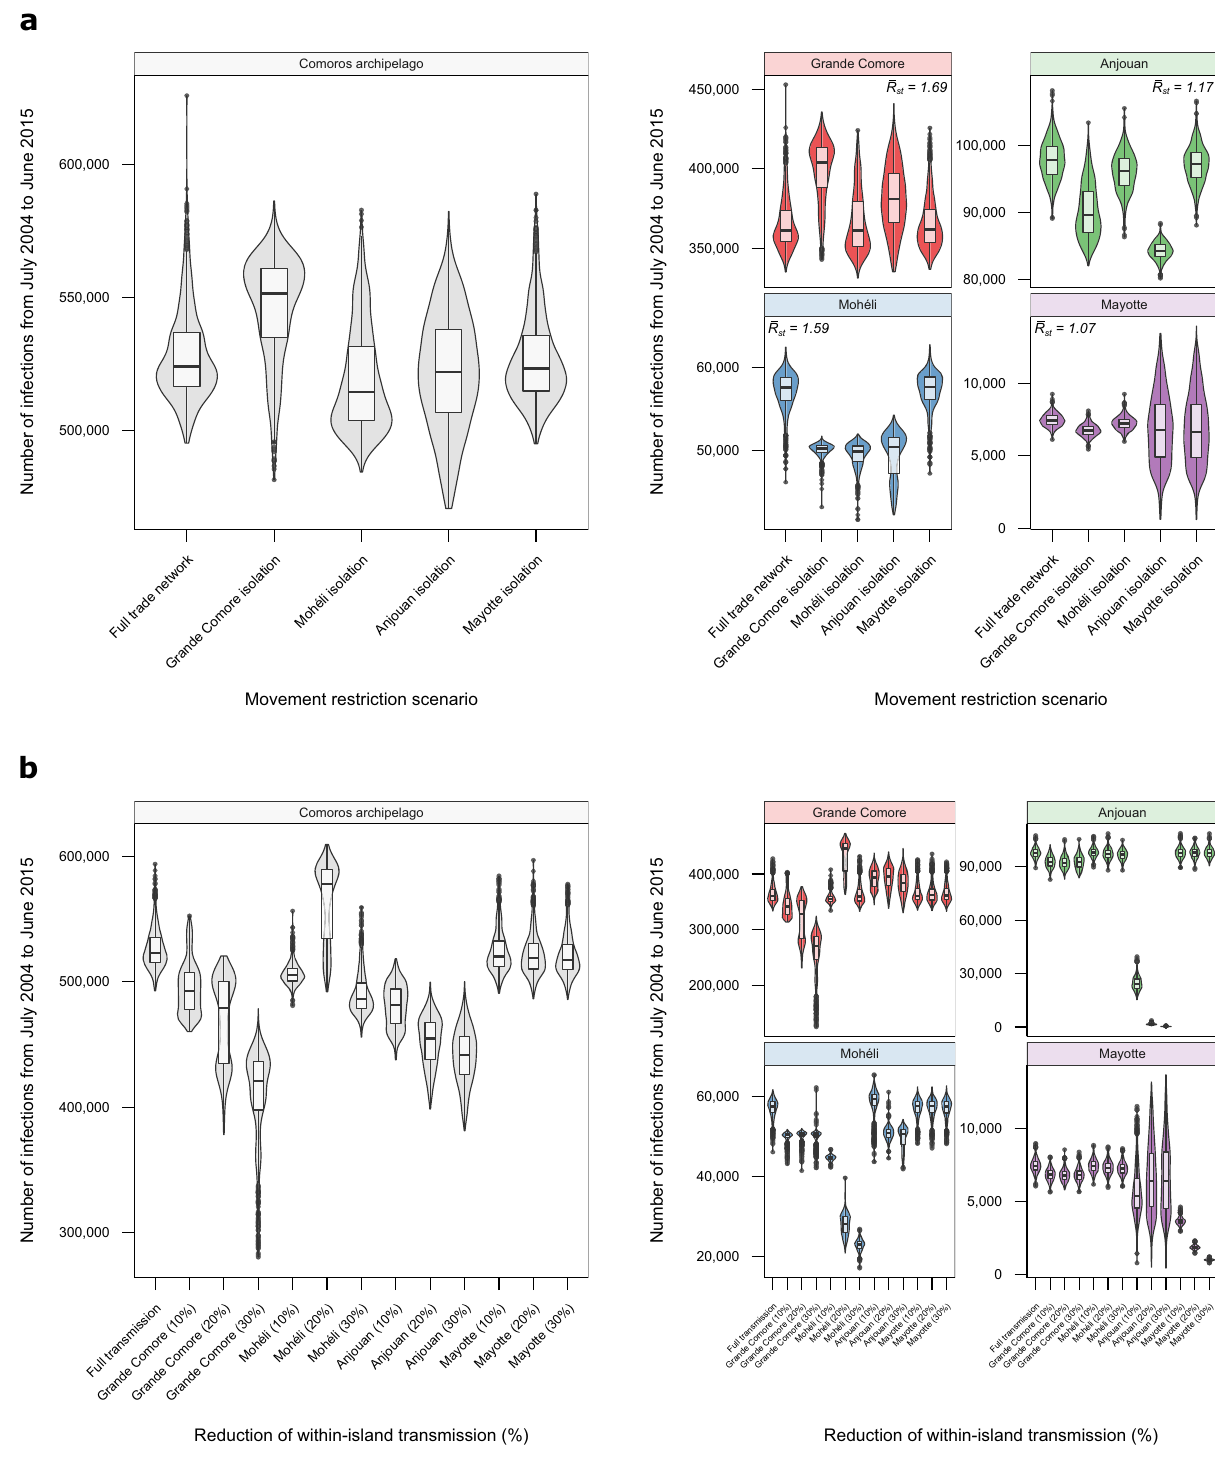
Fig. 5 Effect of control measures on the number of infections in the Comoros archipelago from 2004 to 2015. The total number of infections from July 2004 until June 2015 is shown under each control measure scenario on each island in the Comoros archipelago (grey): Grande Comore (red), Mohéli (blue), Anjouan (green) and Mayotte (purple). a Full (100%) restrictions on imports and exports were placed on each island. For each island, the median estimate of the geometric mean seasonal reproduction number, (cid:1) R , independent of movement restrictions is shown. b Within-island transmission rate was st reduced by 10%, 20% and 30% on each island independently. The shown violins and boxplots were calculated from n = 1000 independent realisations of each control scenario. The central line of the boxplots de fi nes the median with the lower and upper bounds of the box corresponding to the fi rst and third quartiles. The upper whisker extends from the upper bound of the box to the largest value no further than 1.5 × IQR from the upper bound (where IQR is the inter-quartile range). Similarly, the lower whisker extends from the lower bound of the box to the smallest value at most 1.5 × IQR of the lower bound. Data beyond the end of the whiskers are outlying points that are plotted